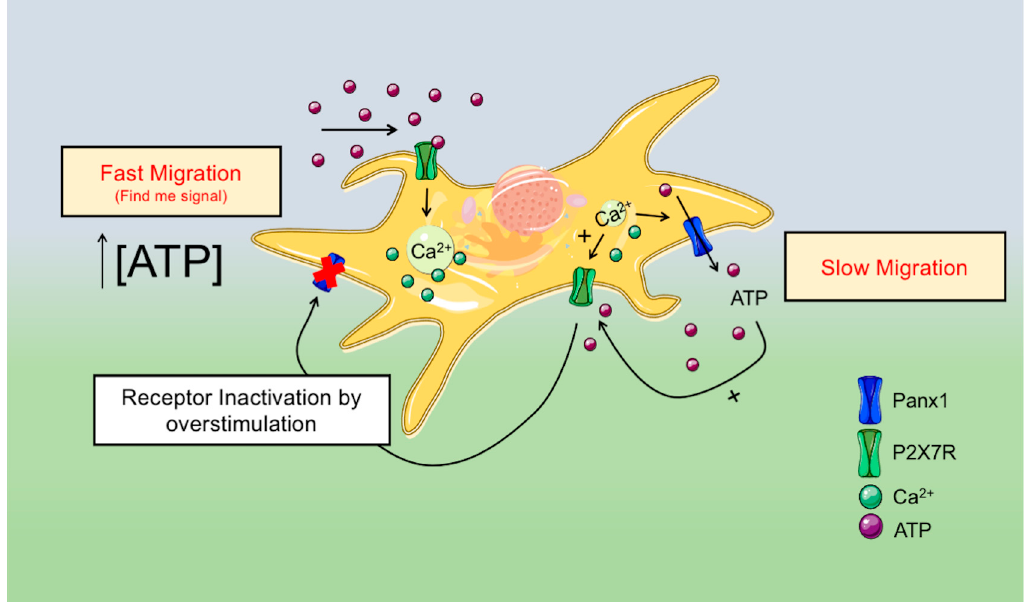
Figure 6. Proposed model for Panx1 channels’ role in HDF migration and cell surface actin dynamics.